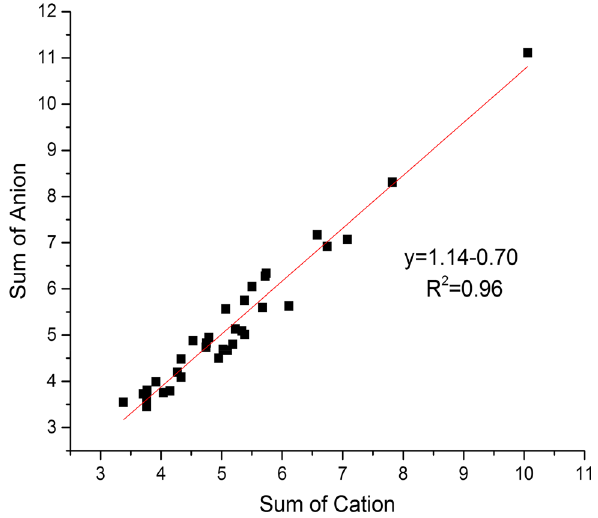
Fig. 7 CBE plot of water samples for monsoon